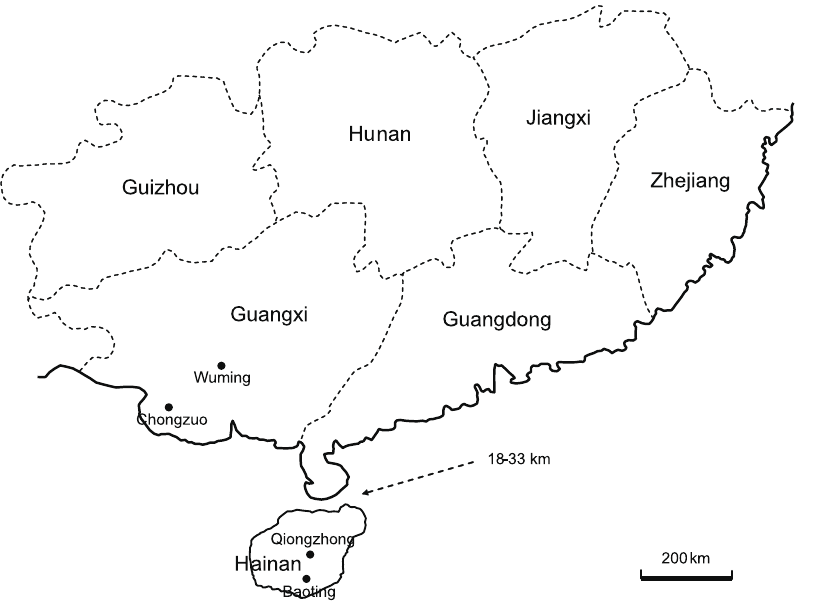
Figure 1. A map showing the strait between Hainan Island and Guangxi Province and the geographical distribution of the collected samples in this study.